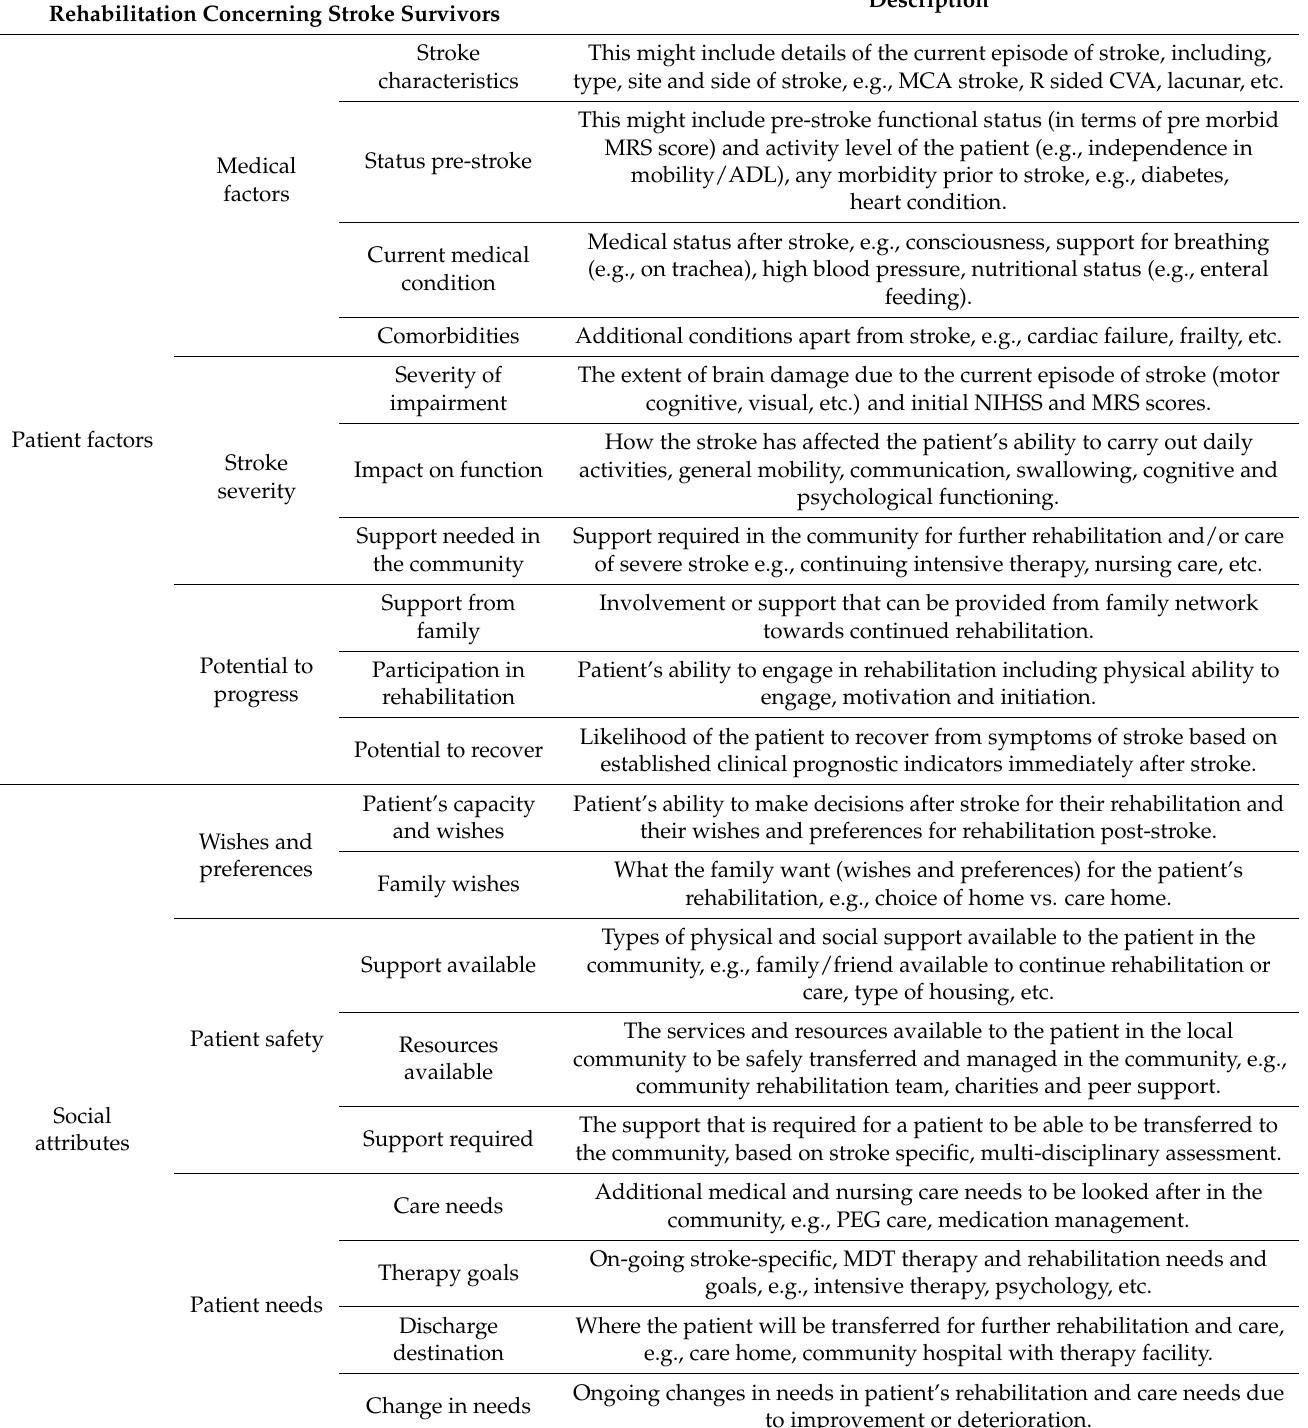
Table A1. Description of